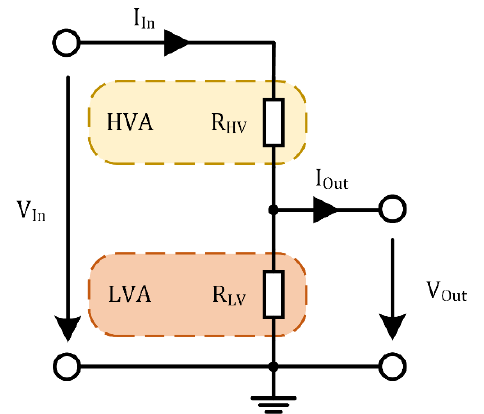
Figure 1. Schematic of a resistive voltage divider consisting of two resistors; one for the high voltage arm (HVA) and one for the low voltage arm (LVA).